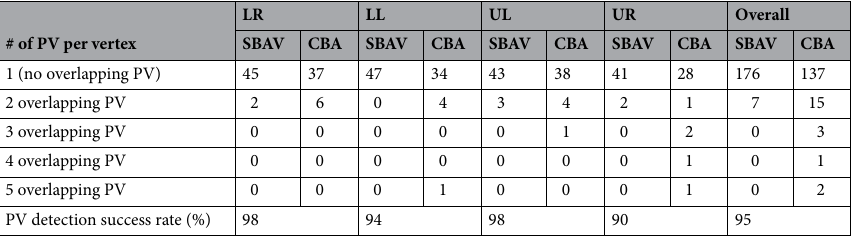
Table 7. Single-subject ROI peak vertex distribution maps. We mapped all single-subject ROI peak vertices per visual quadrant for SBAV and CBA. We quantified alignment precision of these peak vertices by counting for each occipital vertex the number of overlapping peak vertices for SBAV and CBA. The number of single- subject peak vertices per occipital vertex for each visual quadrant before and after macroanatomical alignment (SBAV and CBA) ranged between 1 and 5. Thus, a higher number indicates improved alignment precision of single-subject ROI peak vertices. After CBA, we observed an increase in the number of multiple, i.e. overlapping, single-subject ROI peak vertices per occipital vertex for each visual quadrant and a corresponding decrease in the number of non-overlapping single-subject ROI peak vertices per occipital vertex. The last row contains the success rate of detecting single-subject ROIs and ergo peak vertices for each visual quadrant. Success rates are necessarily equal for SBAV and CBA, because this aspect of our single-subject analysis cannot be influenced by alignment method. PV single-subject ROI peak vertex, LR lower right visual quadrant, LL lower left visual quadrant, UL upper left visual quadrant, UR upper right visual